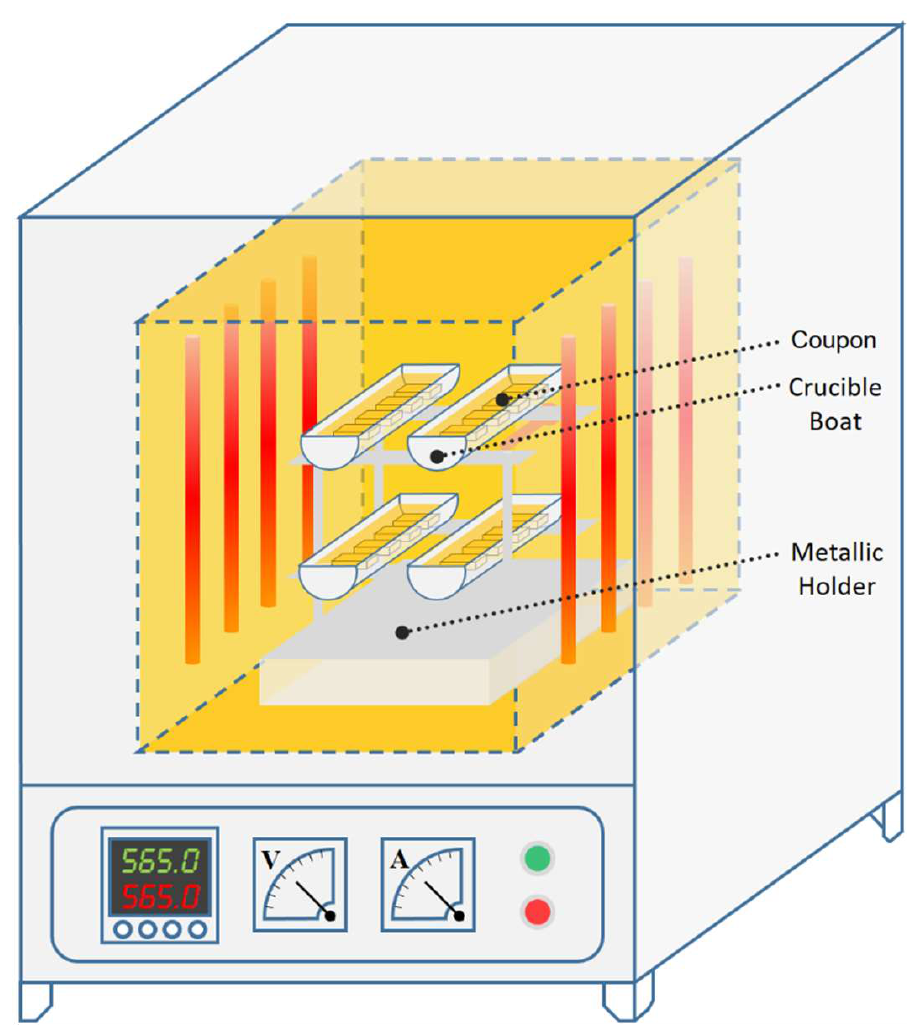
Figure 2. Schematic of corrosion test apparatus used in this study.